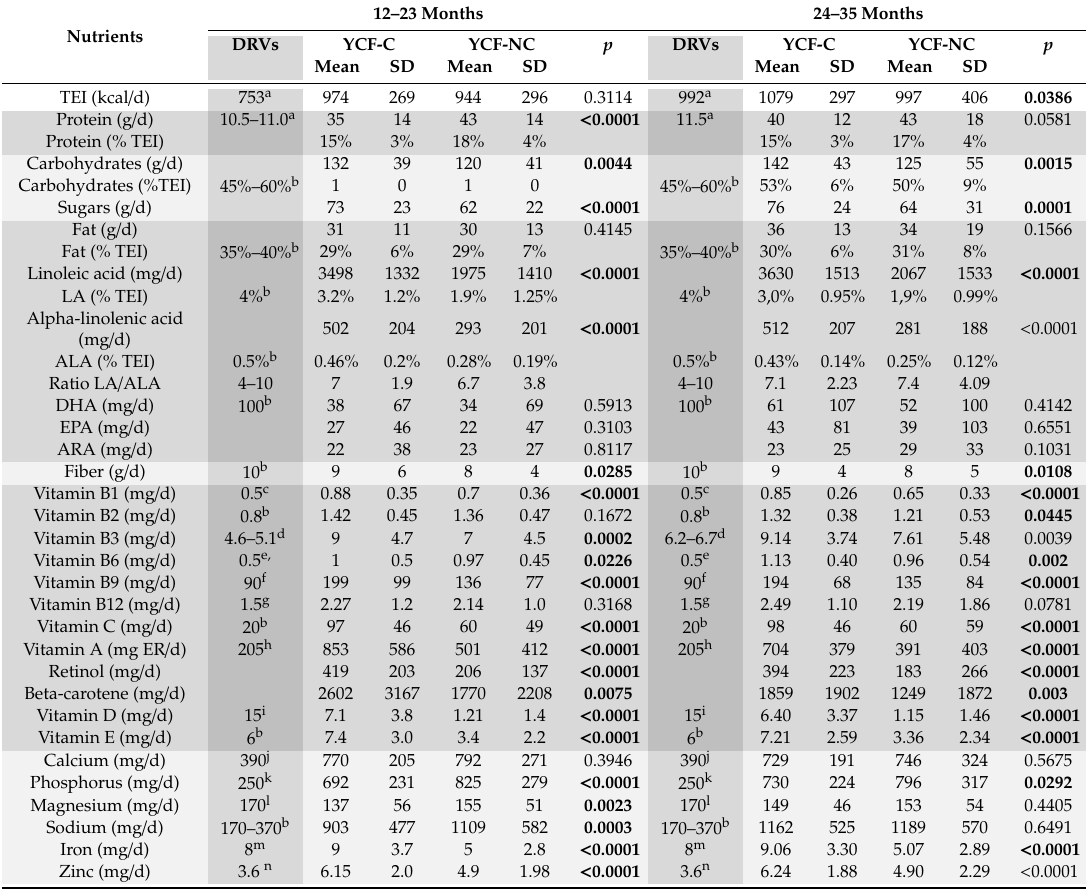
Table 4. Comparison of daily intake between YCF-C and YCF-NC and European Food Safety Authority (EFSA) Dietary Reference Values (DRVs), Average Requirement (AR), or Adequate Intake (AI) in the two age